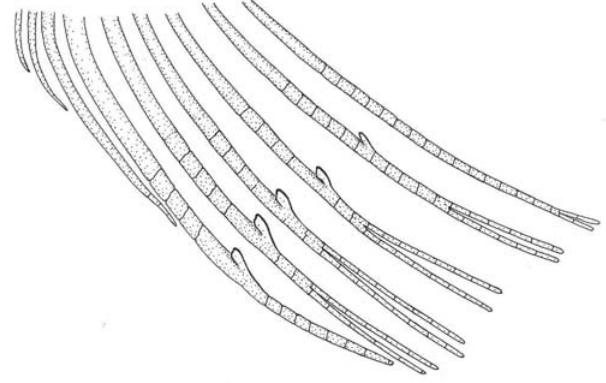
Fig. 56 . Mimagoniates lateralis , adult male, USNM 236088, 31.6 mm SL; anterior 9 anal-fin rays of adult male, lateral view, left side.